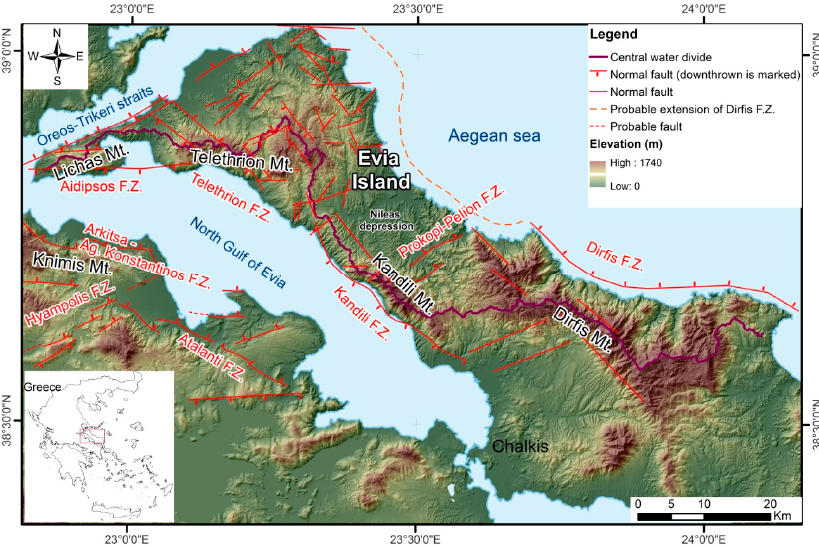
Figure 1. Digital Elevation Model (DEM) of the broader area of the north part of the Evia Island. The main central water divide as well as the main fault zones are also depicted (fault zones are based on several studies and databases [21–30]).